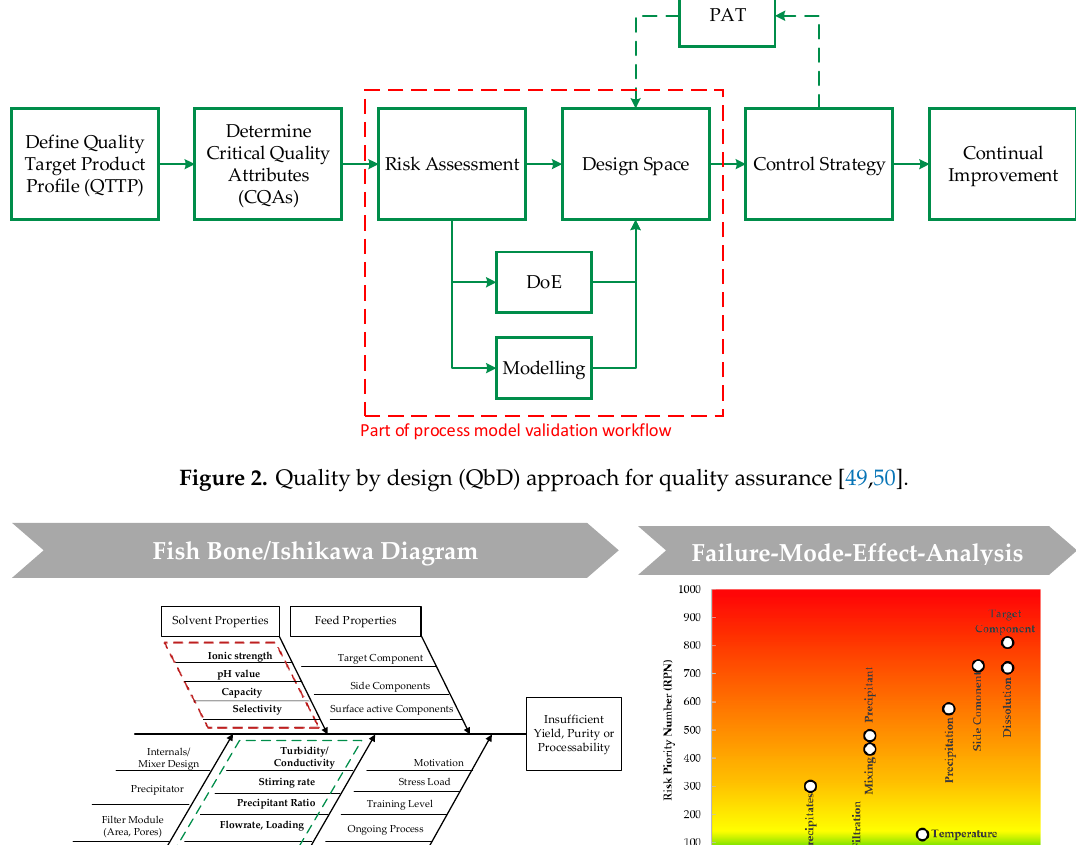
Fish Bone/Ishikawa Diagram